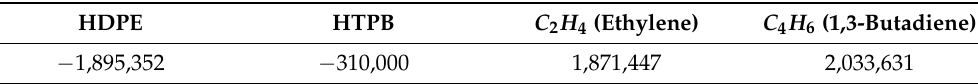
in [J/kg] for fuels and associated monomers f , i